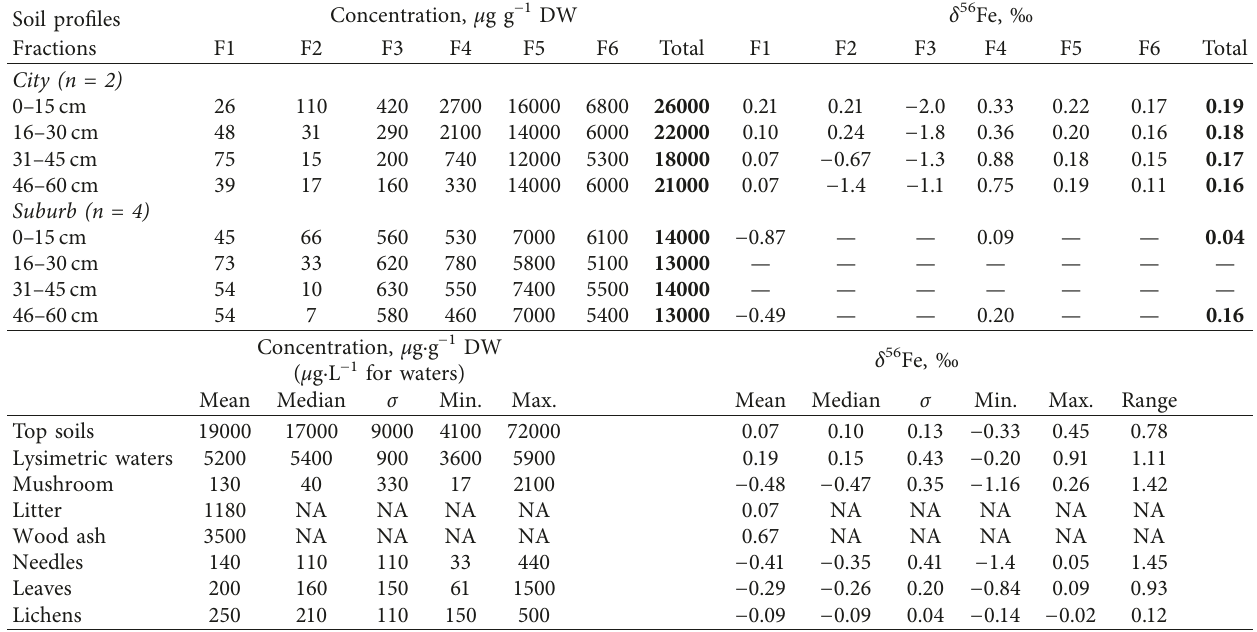
Table 8: Iron concentrations and isotopic composition in environmental samples from Lule˚a.